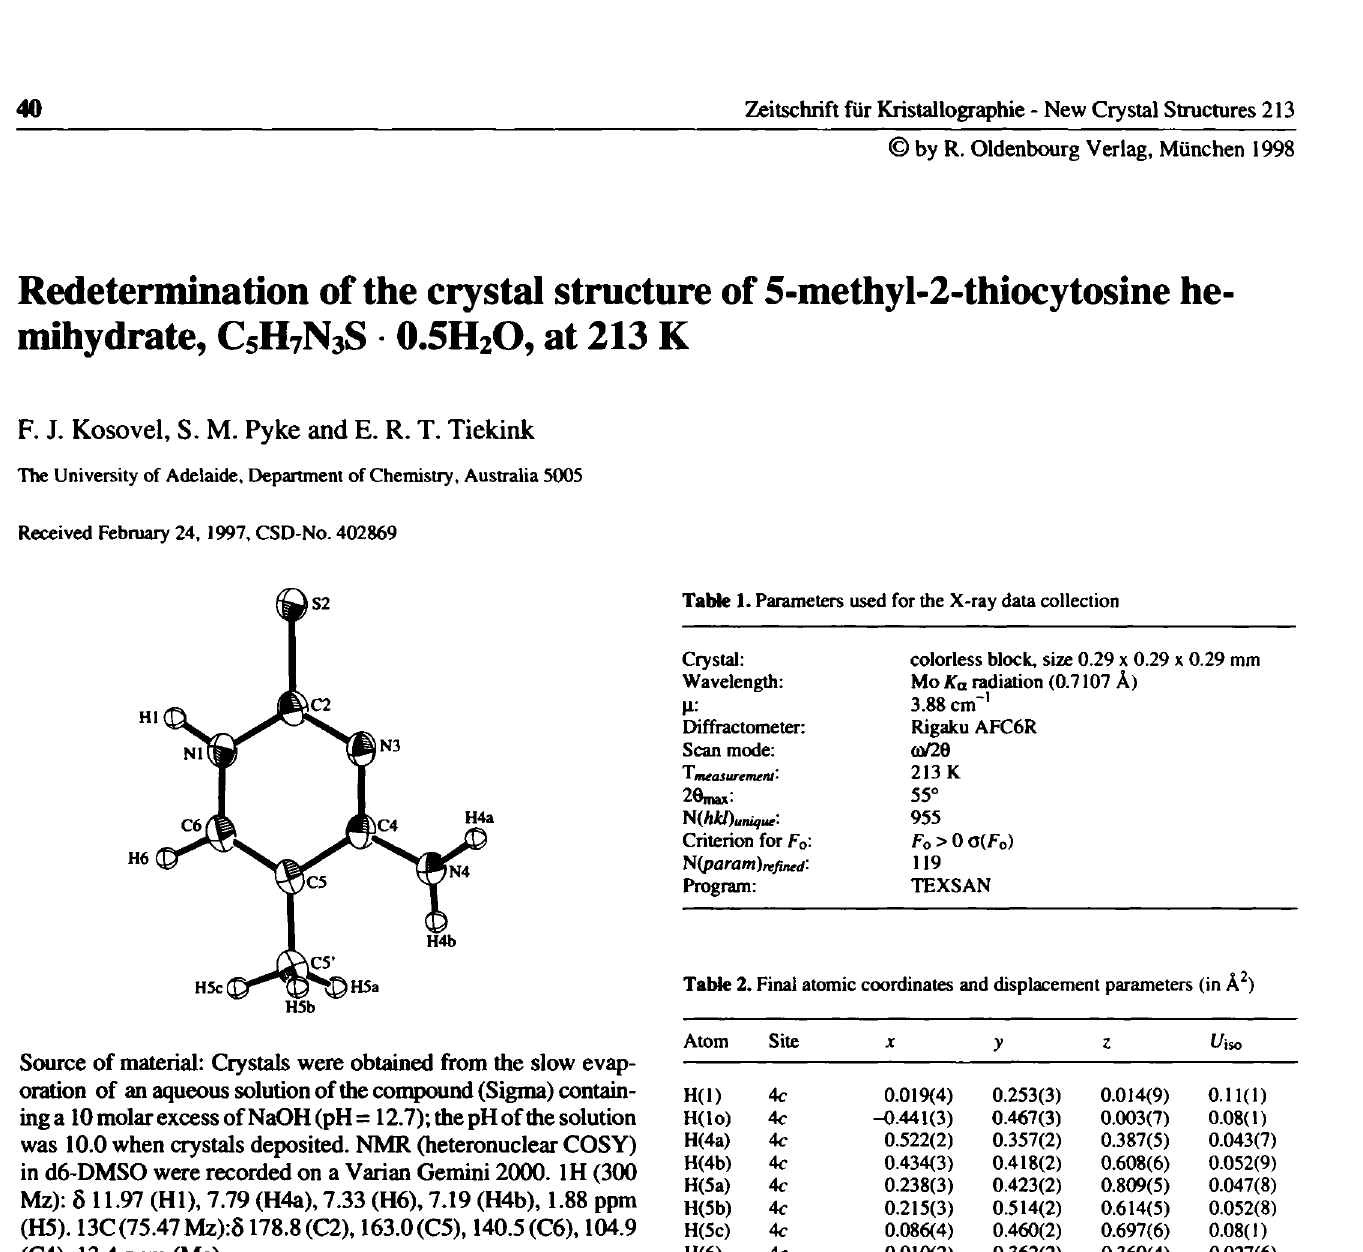
Table 2. Final atomic coordinates and displacement parameters (in